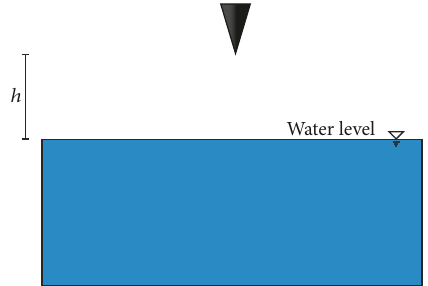
Figure 12: Schematic of drop height of the conical pounder from water surface.